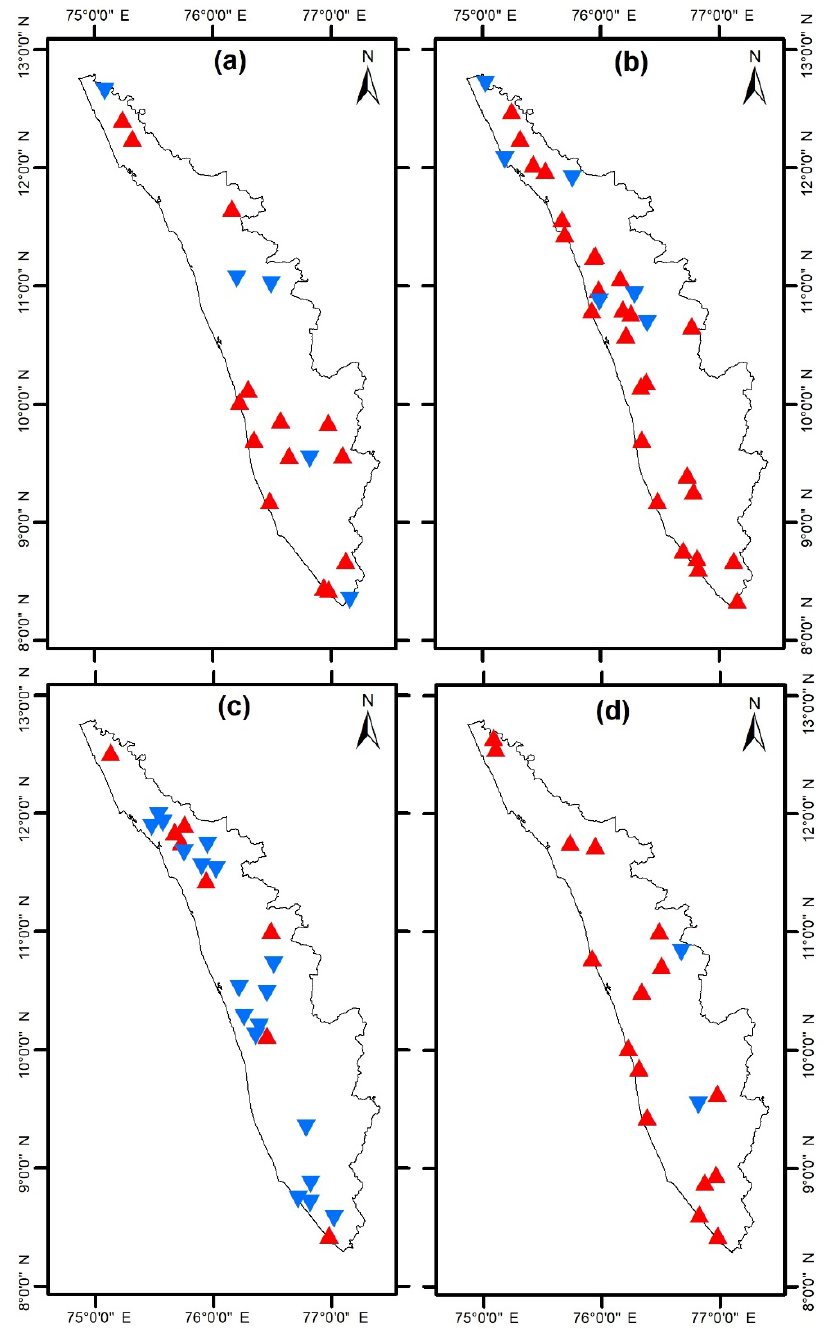
Figure 14. The positive (blue) and negative (red) SMVITERA index trend of locations 19-32-26-18 during ( a ) January, ( b ) April, ( c ) August, and ( d ) November.